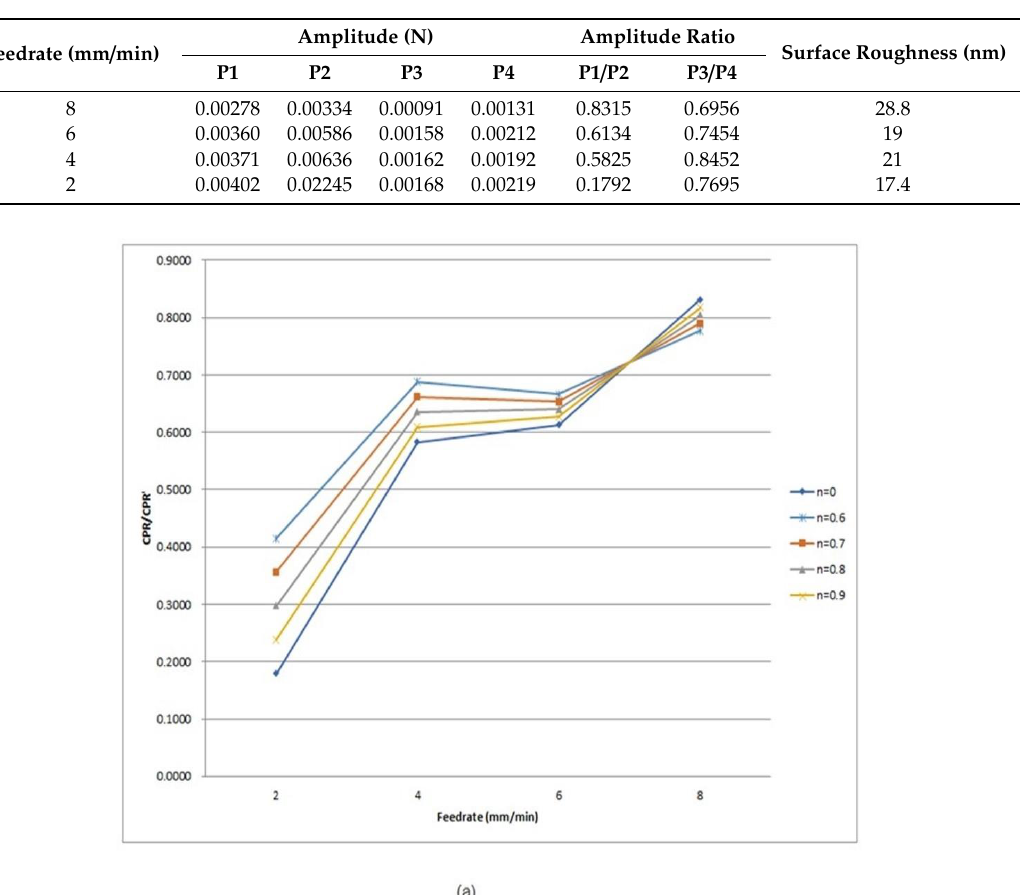
Table 2. The amplitudes of P1 – P4 in the two twin peaks, the ratio of amplitude of P2/P1 and P4/P3 and surface roughness generated in different feed-rate.